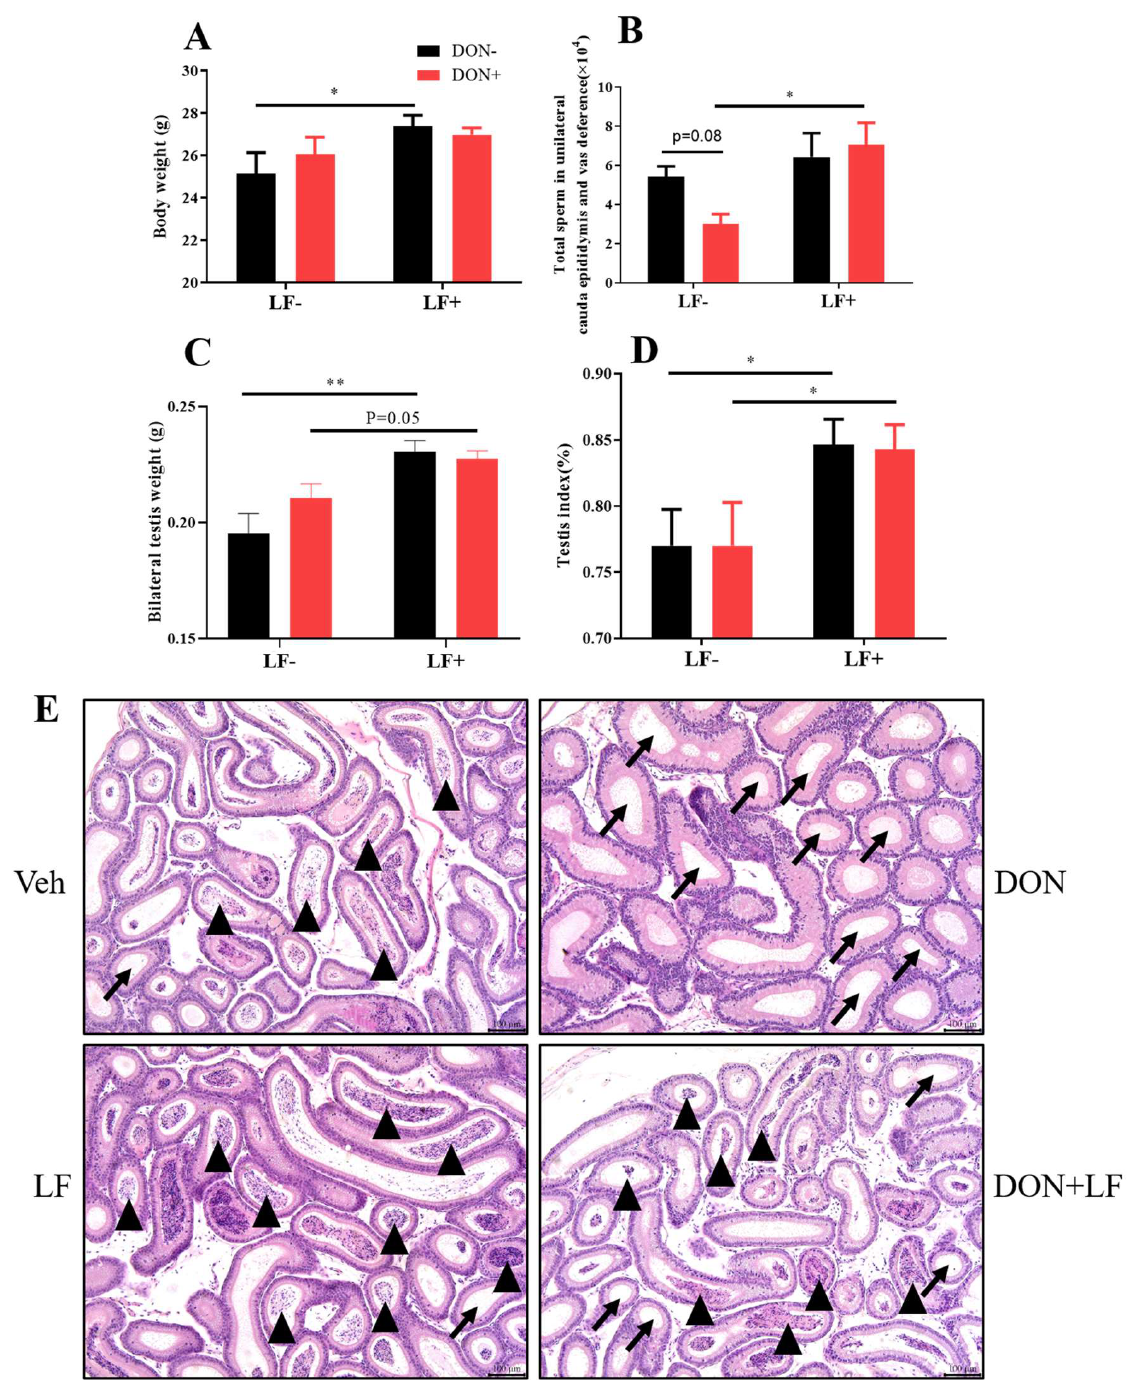
Figure 1. Effects of dietary DON and oral administration of LF on body and testis weight, and sperm count in the epididymis of mice. ( A ) Body weight. ( B ) Total sperm count in unilateral caput epididymis and vas deference. ( C ) Testis weight. ( D ) Index of the bilateral testis. ( E ) Cauda epididymis, histological, arrows indicated tubules with missing sperms and arrowheads indicated tubules with a cluster of sperm. Data were presented as mean ± SEM. For one-way ANOVA, * p < 0.05 and ** p < 0.01.